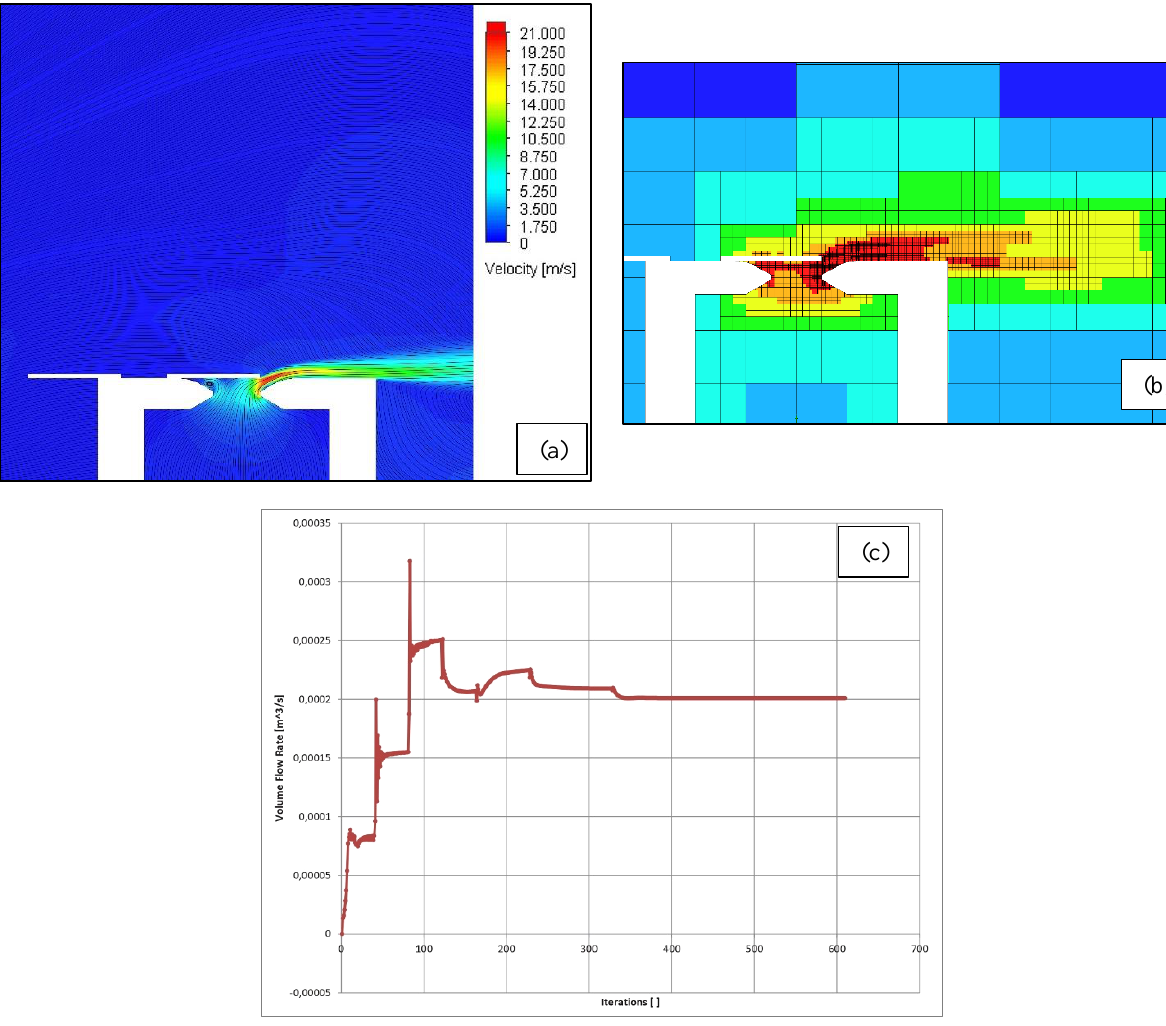
Figure 29. Liquid outflow pattern from a nozzle with a diaphragm for conditions when ∝ = 90 o : a) calculation data; b) a fragment of the adapted computational grid; с) a fragment of the report on the calculation data